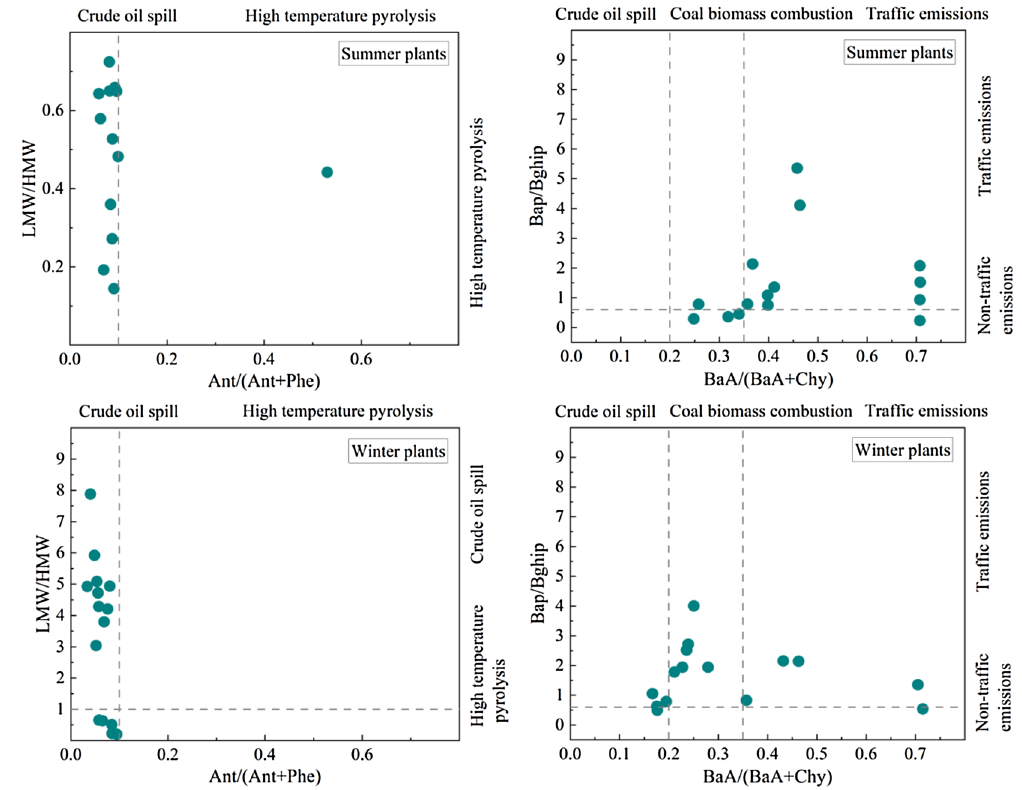
Figure 4. Source analysis of plant PAHs.